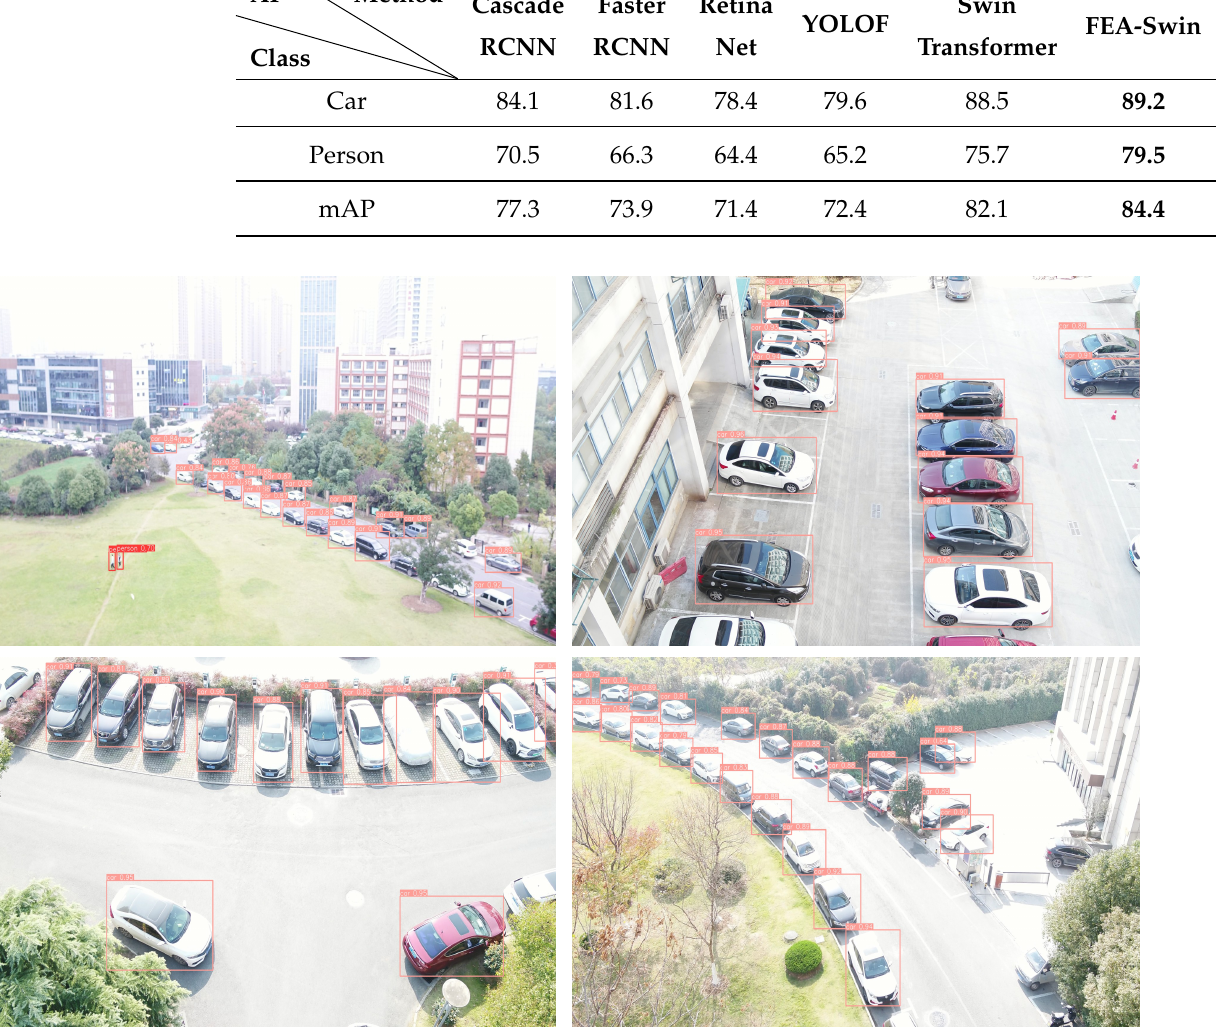
Figure 12. Some examples of detection results on our self-made dataset using